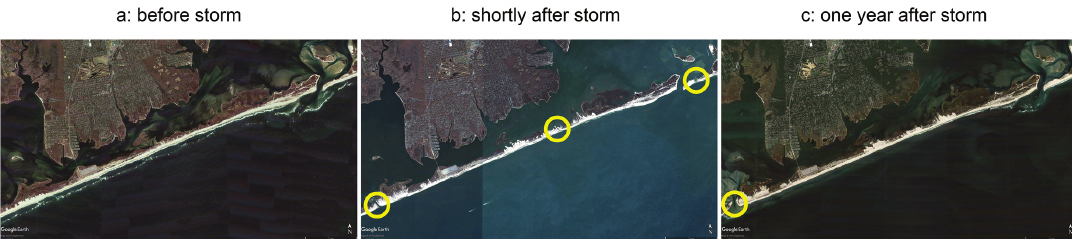
Figure 1. Satellite images of three storm-induced breaches at Fire Island and Westhampton (Long Island, NY, USA) due to hurricane Sandy in 2012 showing: ( a ) before the storm (7 March 2012); ( b ) shortly after the storm (4 November 2012); ( c ) almost one year after the storm (20 September 2013). The location of the breaches is indicated with yellow circles. Retrieved from Google Earth (Map Data: DigitalGlobe, USDA Farm Service Agency).